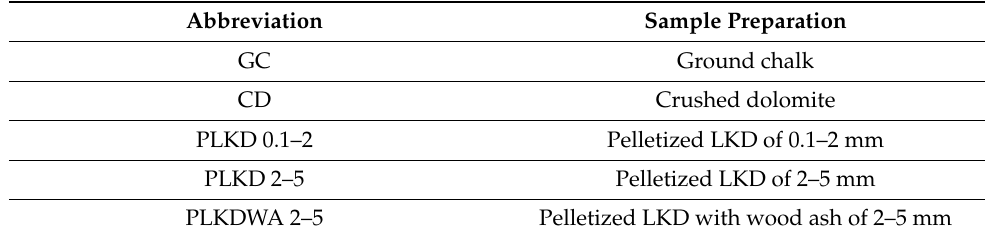
Table 1. Sample description. Abbreviation Sample